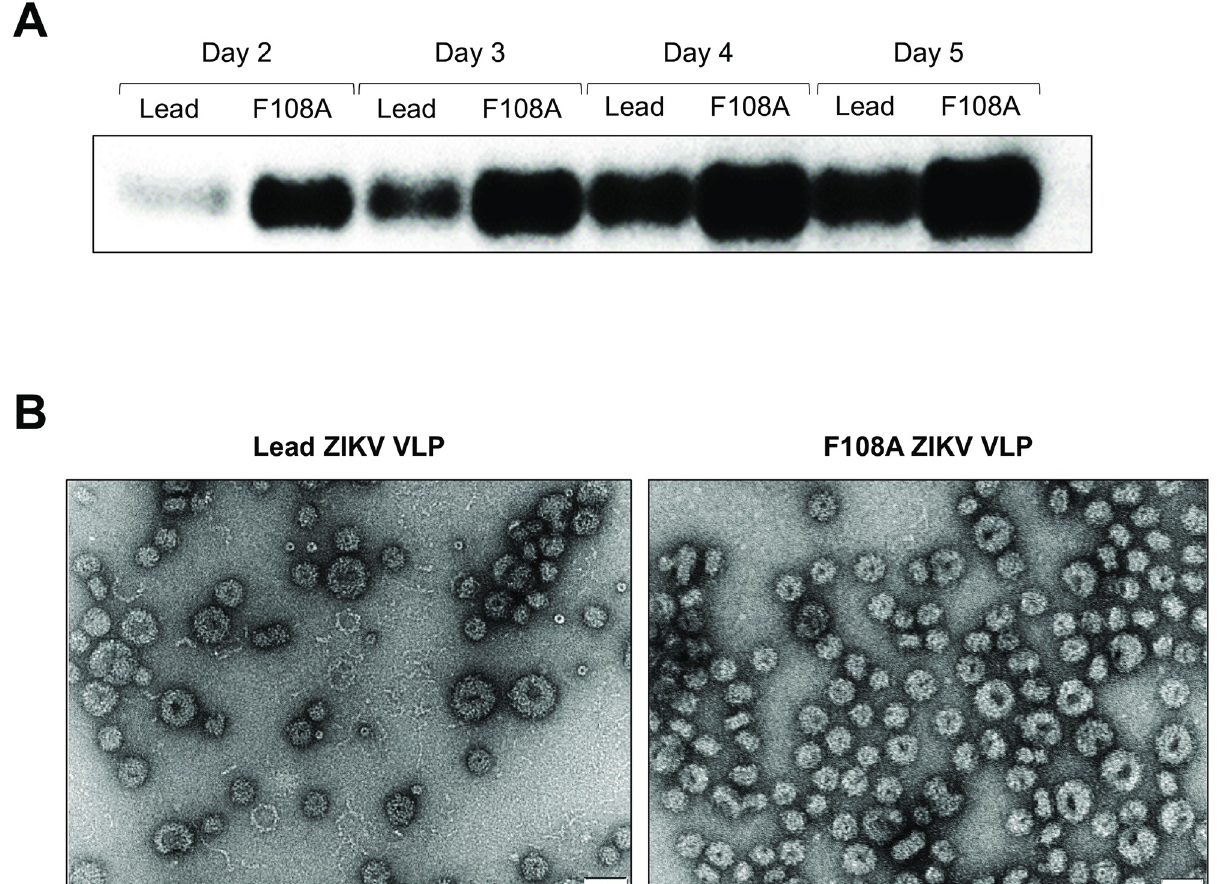
Fig 1. Lead and F108A ZIKV VLP production and Transmission Electron Microscopy (TEM). (A) Western blot of supernatant samples collected on days 2, 3, 4, and 5 days post-transfection (p.t.) from cells transfected with a plasmid containing either the lead or F108A ZIKV VLP cassette. Proteins were stained for E using a mouse ZIKV-specific mAb (MyBiosource, cat#mbs568050). (B) Transmission electron micrographs of purified lead (left panel) and F108A VLPs (right panel) negatively stained with uranyl acetate. The white scale bar depicted on images is 50nm long.